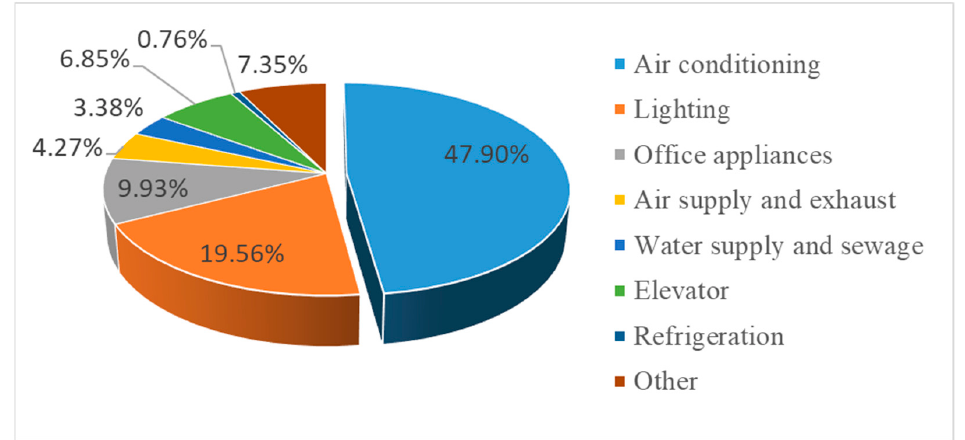
Figure 2. Electricity consumption of office buildings in Taiwan. (Data translated and plotted from Reference [6]).